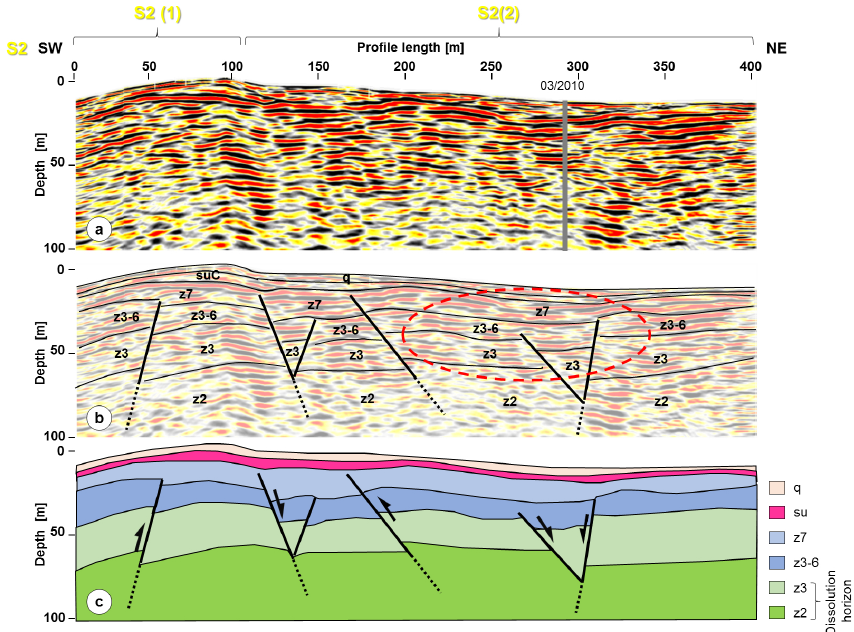
Figure 7. Uninterpreted reflection-seismic profile S2 (a) , with stratigraphy derived from the 03/2010 borehole (b) and with interpretation (c) . The stratigraphic units are explained in Fig. 3. The profile was surveyed south of the sinkhole. Steep-dipping normal and reverse faults within the Permian deposits were identified and in the north-east a bowl-shaped structure (red dashed circle) is visible, which is interpreted as a dissolution-induced